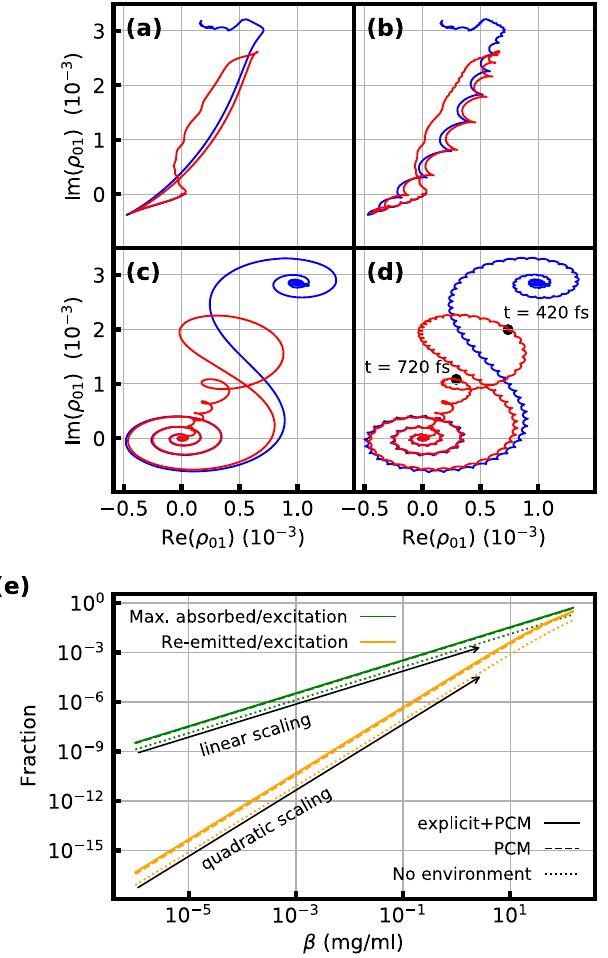
Fig. 4 | Calculated coherence and energy transfer ratios. Calculated vibrational molecular coherence in the symmetric stretching vibrational mode of the DMSO 2 molecule in solution displayed in a frame rotating with the vibrational eigen- frequency. The calculations are done with a the compressed pulse using the RWA, b the compressed pulse without the RWA, c the chirped pulse using the RWA, and d the chirped pulse without the RWA. The red curves include relaxation; the blue curvesdonotincluderelaxation.Eachbumpofthecycloidin b correspondstoone half-cycleoftheelectric fi eld,showingthatenergytransferfromtheexcitation fi eld tothemolecularsystemiscompletedafter3to4 fi eldcycles(Fig.2b)inthecaseof the FCE. In d , the time points that are maxima of CET( t ) caused by the symmetric stretching vibration are marked with black dots. e Re-emitted (orange) and max- imum absorbed (green) fraction of the impinging pulse energy versus concentra- tion. The results were obtained from the impulsive-regime model (see Supplementary Information) with the FCE and ab initio Lorentz parameters. The solidlinesincludedirectinteractionswiththesurroundingwaterandthescreening effectofthepolarizablecontinuum,thedashedlinesonlythelatter,andthedotted lines neither. For small concentrations, the maximum absorbed energy scales lin- early with concentration. In contrast, the coherent re-emission, containing the spectroscopic information, scales quadratically with concentration.